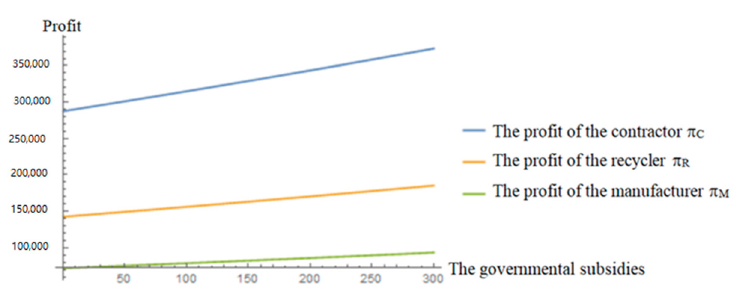
Figure 8. Effects of governmental subsidies on the profits.